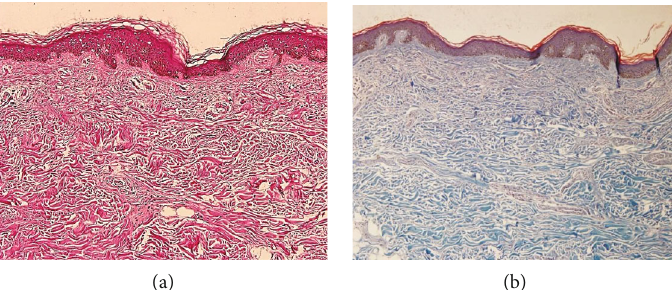
Figure 5: Human skin before the process of creating the skin-derm sca ff old at magni fi cation 10x: (a) H-E stain; (b) H-SG